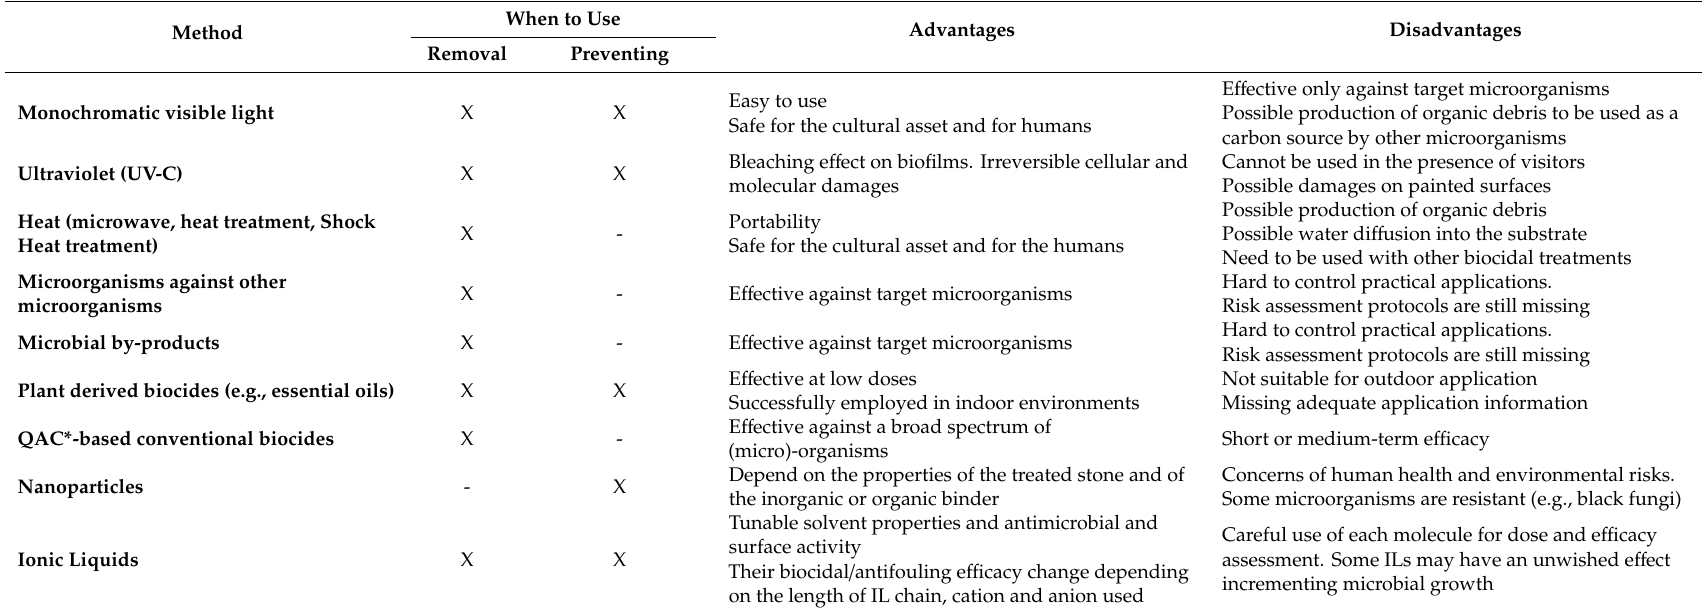
Table 2. Pros and cons of current direct methods and their